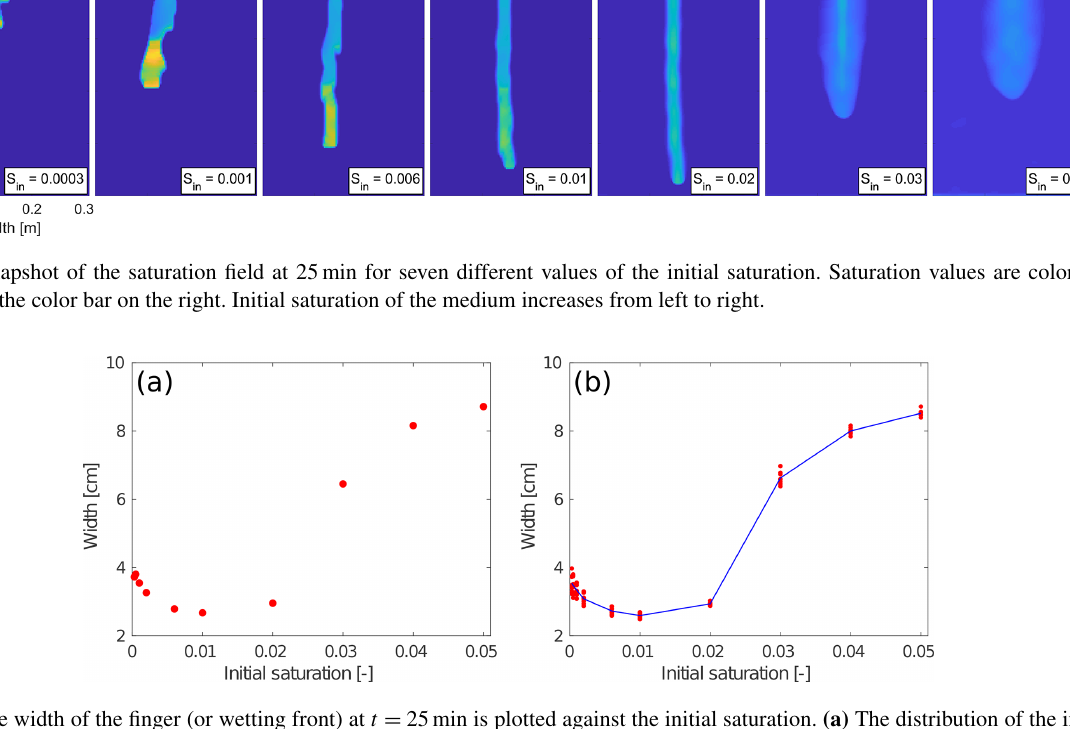
Figure 5. The width of the finger (or wetting front) at t = 25min is plotted against the initial saturation. (a) The distribution of the intrinsic permeability given by Fig. 3. (b) All simulations given by eight different distributions of the intrinsic permeability (see Fig. 3 and Fig. A2). The blue line connects the